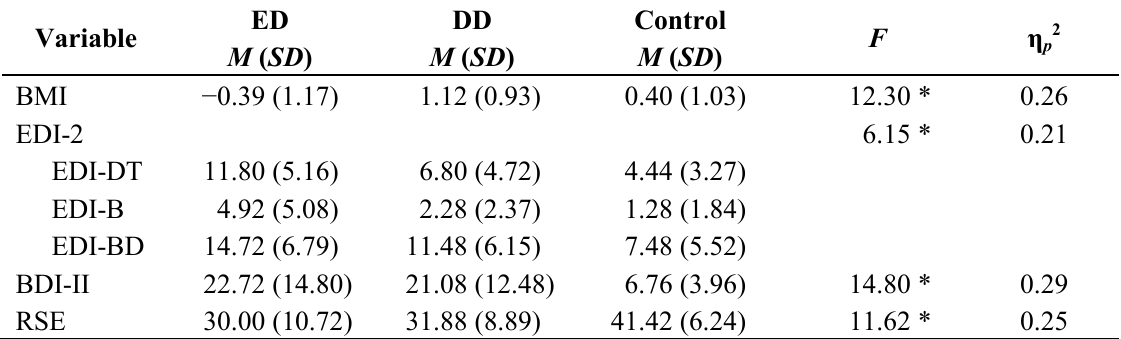
Table 1. Descriptive Statistics and ANOVA Results for Body Mass Index, Eating Disorder Inventory-2 scores, Beck Depression Inventory-II scores, and Rosenberg Self-Esteem Scale Scores.